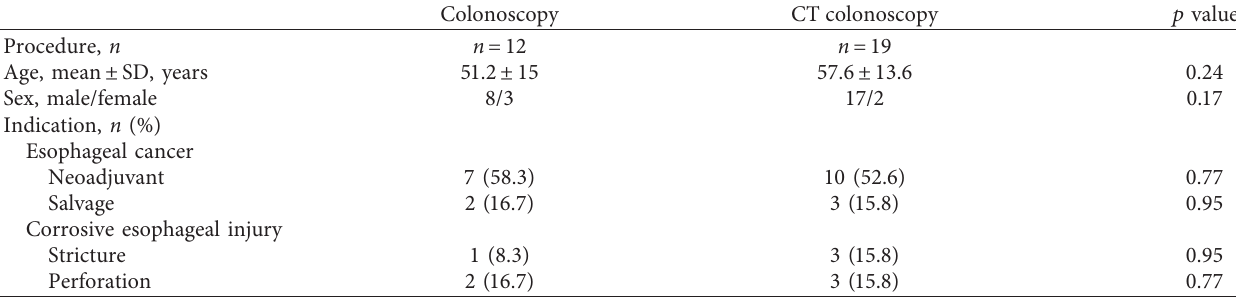
Table 2: Characteristics of patients treated by colonic interposition.